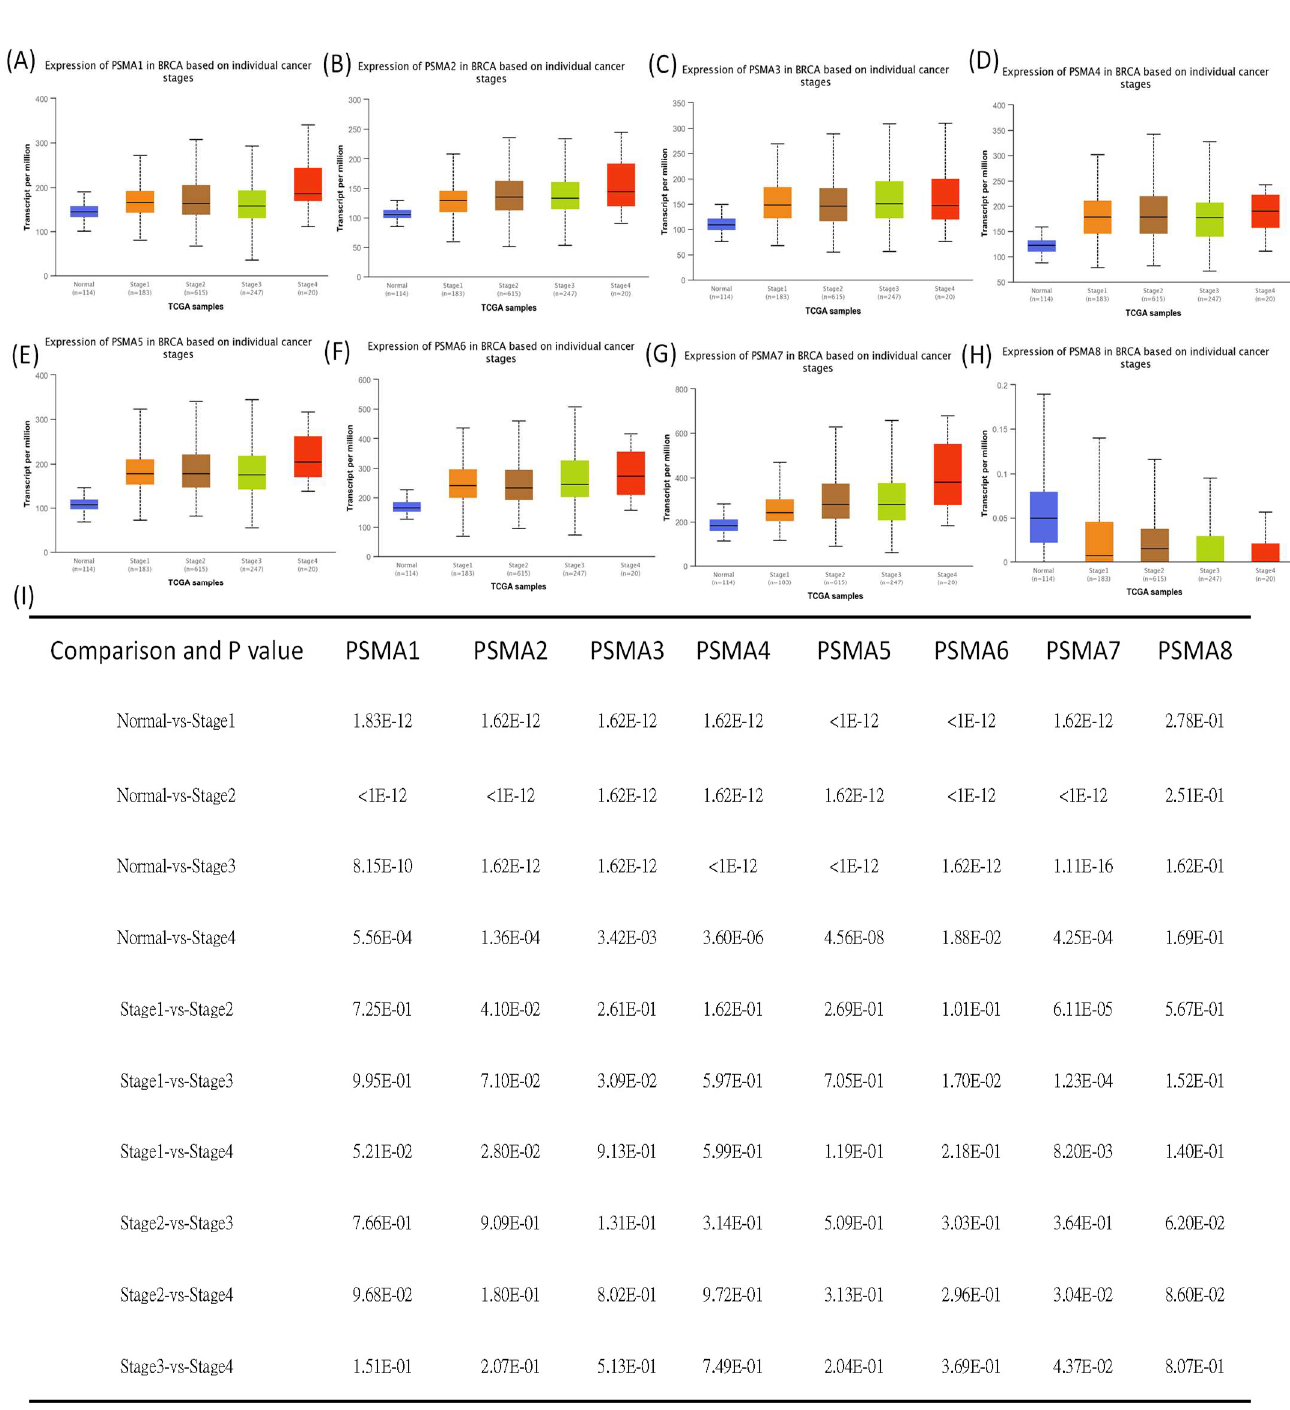
Figure 2. Proteasome 20S subunit alpha ( PSMA ) family gene transcription levels in different stages of breast cancer patients. ( A – H ) Box plot shows relative expression levels of PSMA family genes in normal samples ( n = 114), and stage 1 ( n = 183), stage 2 ( n = 615), stage 3 ( n = 247), and stage 4 breast cancer ( n = 20). ( I ) The table shows relative expression levels of PSMA family genes in different BRCA stages; p < 0.05 was considered statistically significant.